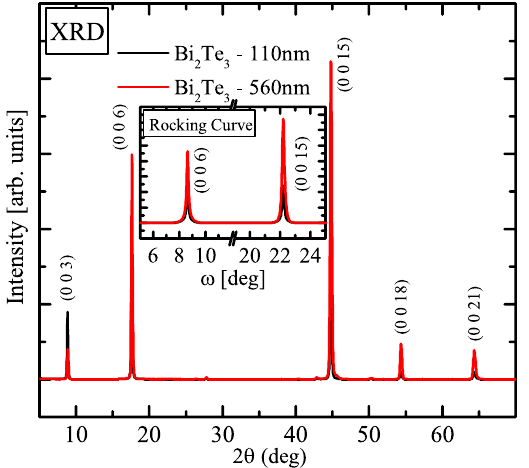
Figure 1. X-ray diffraction results show the high quality crystallinity of the Bi 2 Te 3 thin films created using pulsed laser